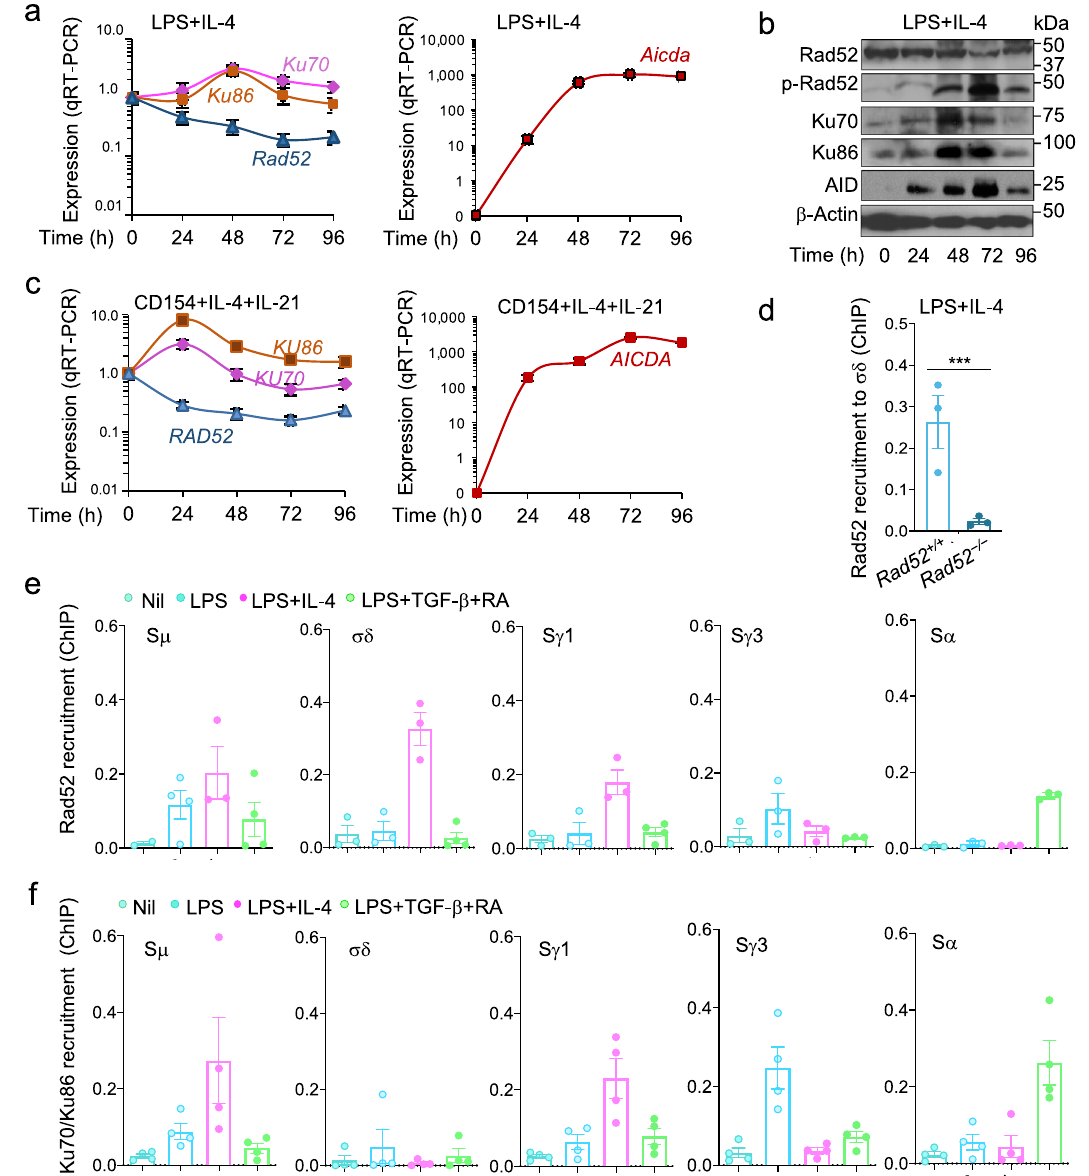
Fig. 6 Rad52 is phosphorylated and recruited to S μ and σδ in B cells induced to undergo IgD CSR. a C57BL/6 mouse naïve IgM + IgD + B cells were stimulated with LPS plus IL-4 and cultured for 0, 24, 48, 72 and 96h. Rad52 , Ku70 , Ku86 , and Aicda transcripts were analyzed by real-time qRT-PCR, normalized to β -Actin expression, and depicted as relative to the expression in unstimulated B cells (set as 1.0). Data are mean±SEM of three independent experiments. b Expression of Rad52, phosphorylated Rad52 (p-Rad52), AID, Ku70, Ku86, and β -Actin proteins in mouse B cells stimulated with LPS plus IL-4 (as in a ), as analyzed by speci fi c immunoblotting. Data are one representative of three independent experiments yielding comparable results. c Human peripheral blood naive IgM + IgD + B cells were stimulated with CD154 plus IL-4 and IL-21 and cultured for 0, 24, 48, 72 and 96h. RAD52 , KU70 , KU86 , and AICDA transcripts were analyzed by real-time qRT-PCR, normalized to β -ACTIN expression, and depicted as relative to the expression in unstimulated B cells (set as 1.0). Data are mean±SEM of three independent experiments. d Recruitment of Rad52 to σδ region DNA, as analyzed by ChIP-qPCR assays in mouse Rad52 + / + and Rad52 − / − B cells stimulated with LPS plus IL-4 and cultured for 72h. Data are expressed as percent of pre-IP input for each sample (mean±SEM of three independent experiments). *** p <0.001 (unpaired two-tailed t -test). e , f C57BL/6 mouse naïve IgM + IgD + B cells were stimulated with nil, LPS alone, LPS plus IL-4, or LPS plus TGF- β and RA and cultured for 72h. Recruitment of Rad52 ( e ) and Ku70/Ku86 ( f ) to S μ , σδ , S γ 1, S γ 3, and S α region DNA, as analyzed by ChIP-qPCR assays. Data are mean±SEM of three or four independent experiments. Source data are provided as a Source Data fi re fl ection of high levels of V H DJ H − C δ s transcripts in bone mar- (Fig. 10h). Increased CSR to IgD in MRL/ Fas lpr/lpr mice was row, spleen, MLNs and Peyer ’ s patches B cells as well as increased characterized by greater frequency and length of micro- numbers of IgD + B cells in lamina propria, MLNs and Peyer ’ s homologies in S μ – σδ as compared to S μ – S γ 1 and S μ – S α junc- patches (Fig. 10f, g and Supplementary Fig. 9c). In MRL/ Fas lpr/lpr tional sequences, as well as a high frequency of somatic point- mice, the elevated IgD levels re fl ected the increased numbers of mutations in areas abetting S μ -S δ DNA junctions (Fig. 10i, j and IgD-producing cells and increased B cell S μ – σδ DNA recombi- Supplementary Fig. 10). In both SLE patients and lupus MRL/ nation in bone marrow, spleen, MLNs and Peyer ’ s patches Fas lpr/lpr mice, the high level of CSR to IgD, total IgD and IgD